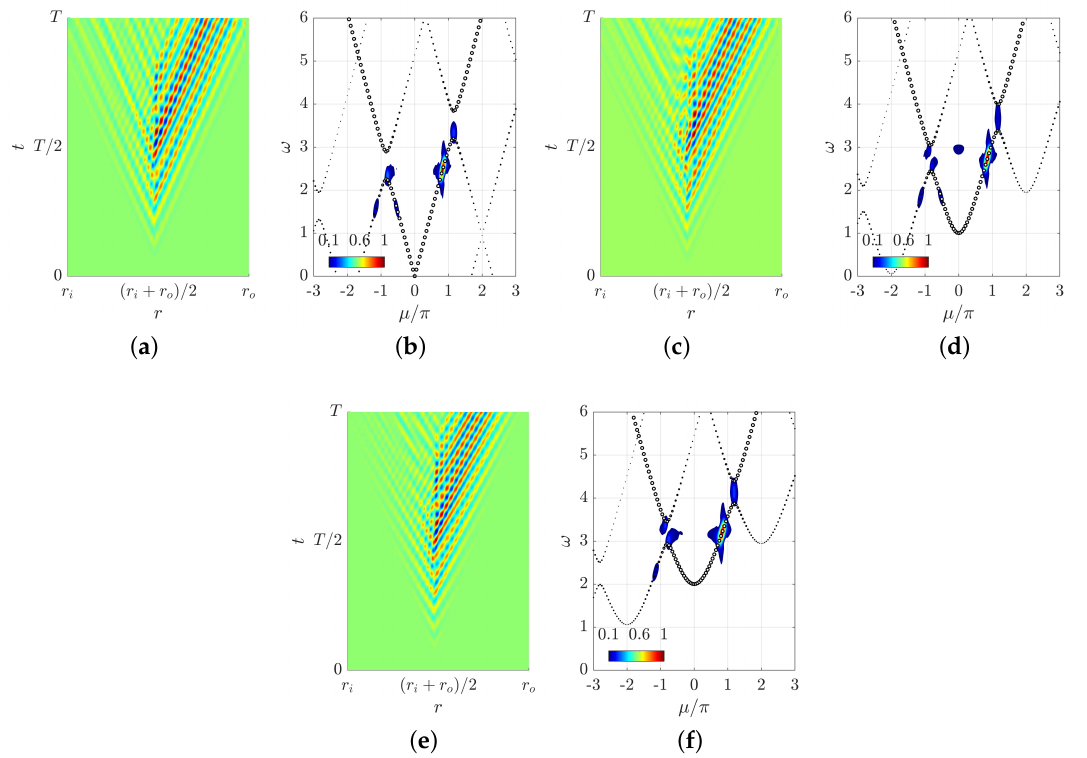
Figure 6. One-way wave propagation for a space–time modulated SRC with excitation in the middle of the ring structure and associated numerical and PWEM dispersion. ( a , b ) Monopole, ( c , d ) dipole, and ( e , f ) quadrupole excitation. The energy mainly propagates from the central portion to the outer shell, while propagation to the inner shell is not